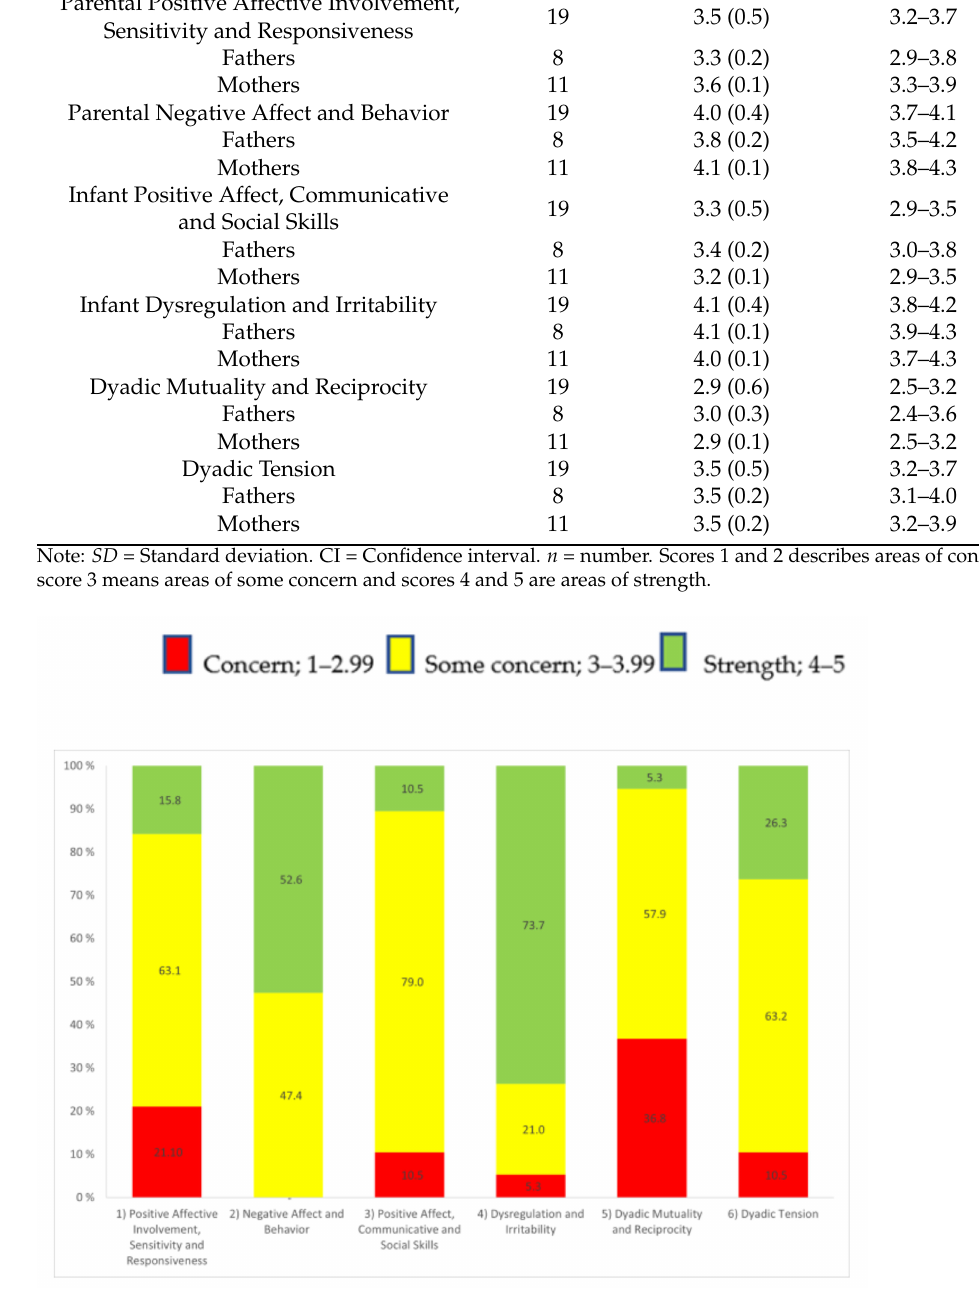
Figure 1. The six subscales with percentages in the three Parent–Child Early Relational Assessment categories: concern, some concern, and